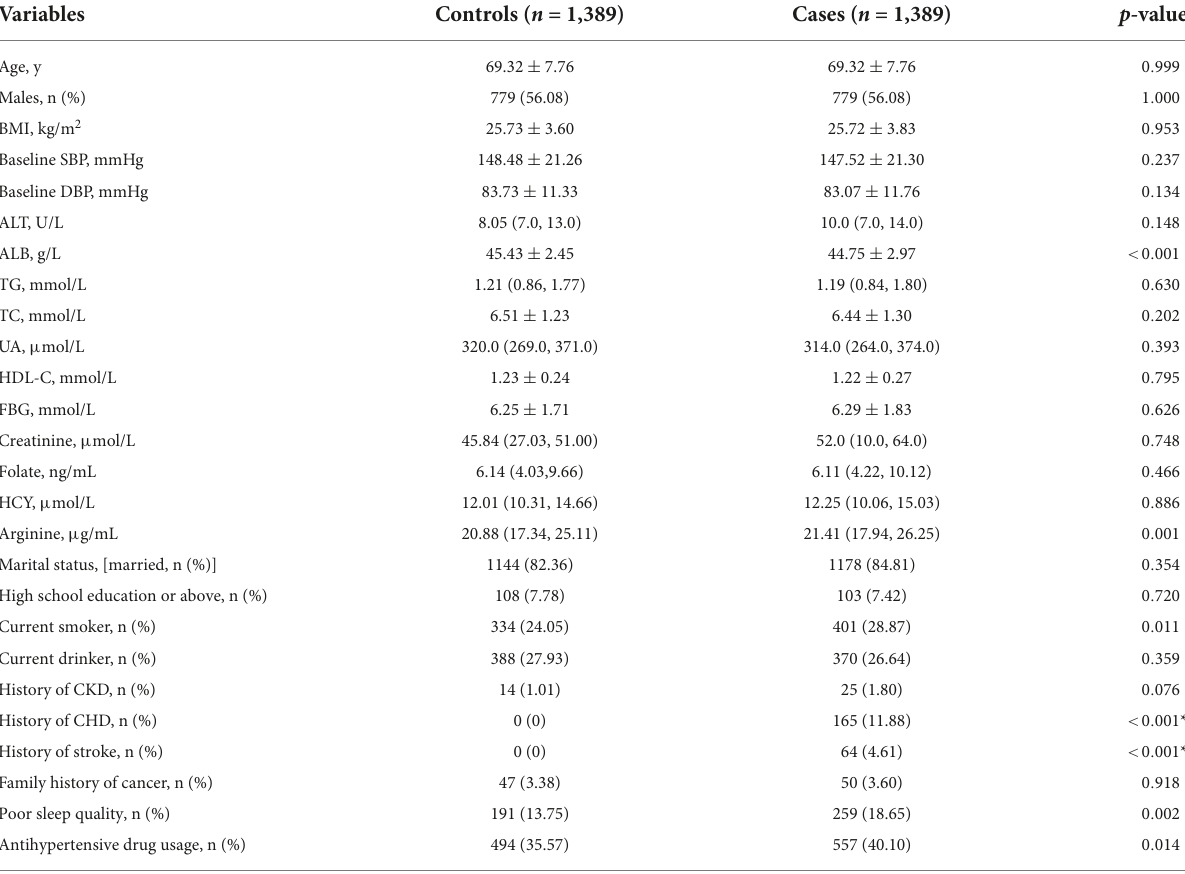
TABLE 1 Baseline characteristics of the cancer cases and matched